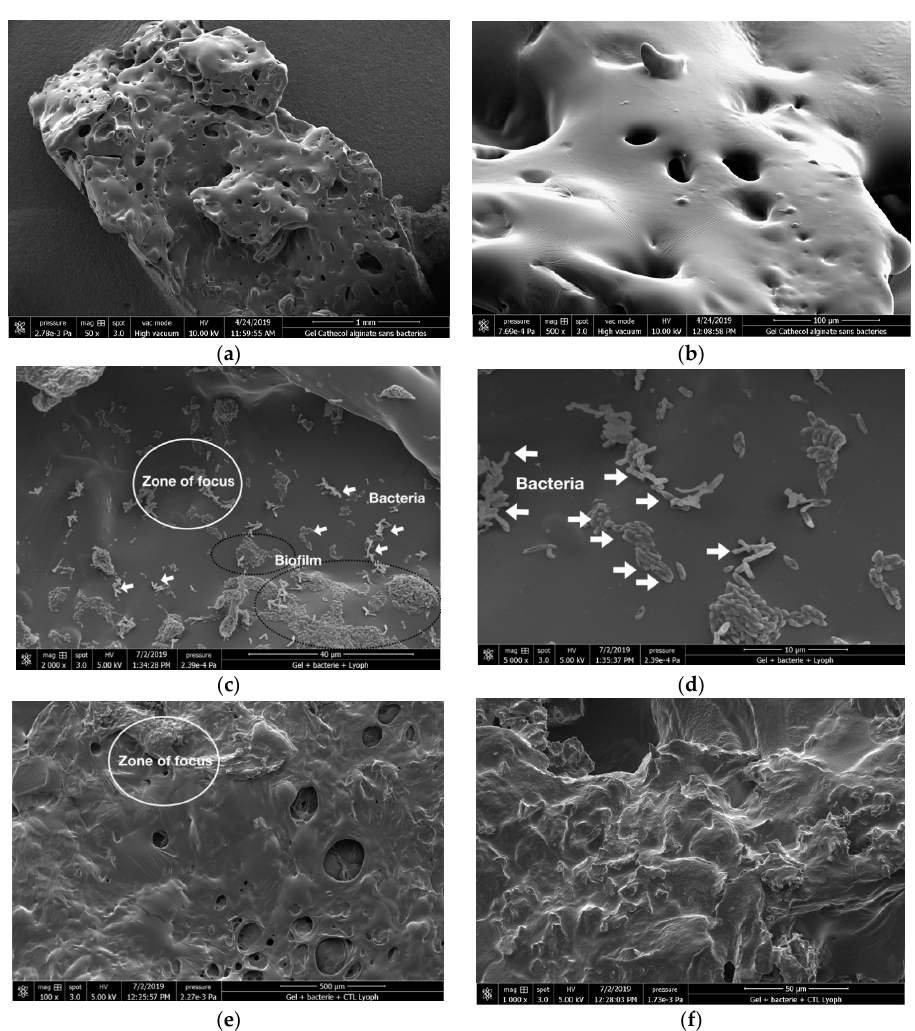
Figure 6. Alg–Cat 1% with/without antimicrobial agent and P. gingivalis (MEB view). ( a , b ) Gel presents a porous structure that could be layered by biofilm; ( c , d ) P. gingivalis colonize the surface and pores when an antibacterial agent is not present; ( e , f ) when charged with D-CTL, no bacteria were found at 24